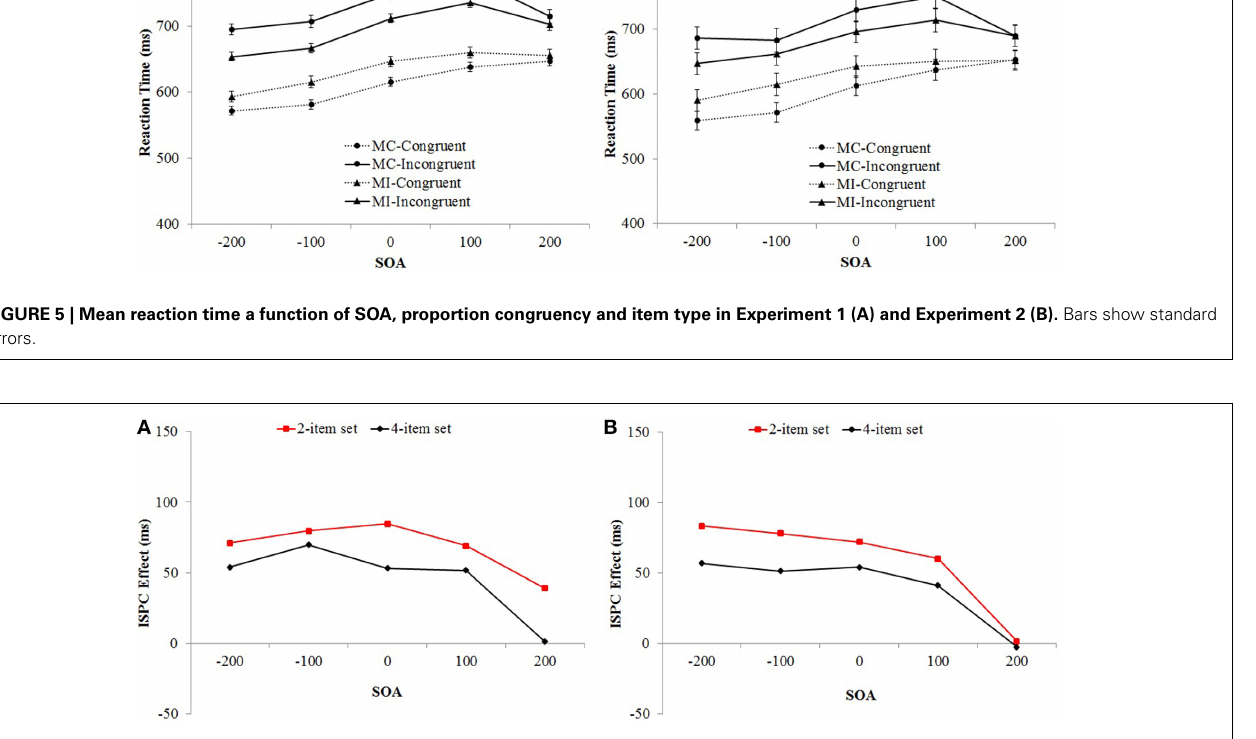
FIGURE 6 | Mean ISPC effect a function of set size and SOA in Experiment 1 (A) and Experiment 2 (B).